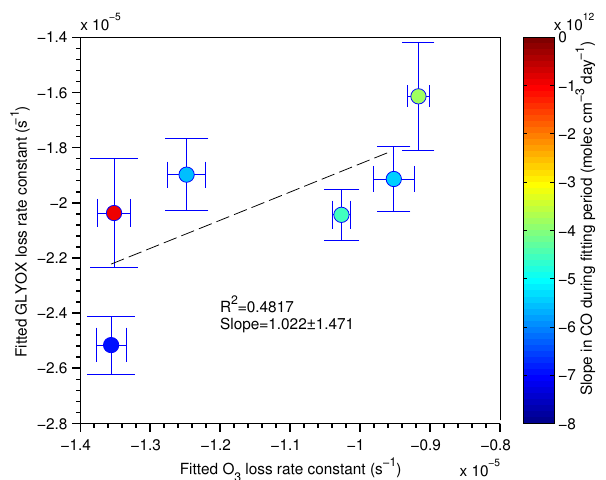
Fig.3. FitteddepositionratesforglyoxalandO 3 fromdatatakenat Fig. 3. Fitted deposition rates for glyoxal and O 3 from data taken at BEARPEX 2007. Color coding of points indicates the slope in CO, BEARPEX 2007. Color coding of points indicates the slope in CO, an indicator of the stability or dilution of the airmass. an indicator of the stability or dilution of the